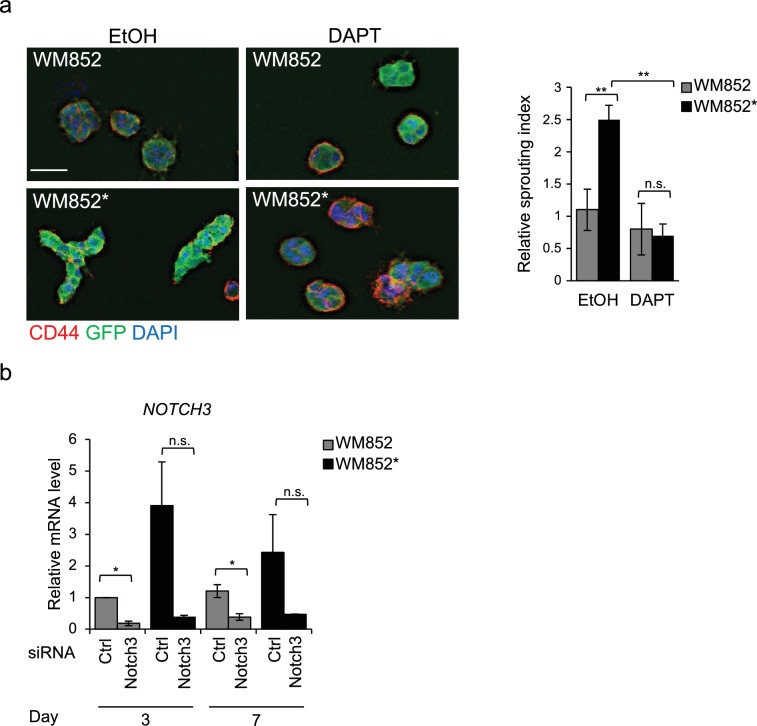
3D growth phenotype of metastatic melanoma cells is Notch3 dependent.(a) Representative images (left) and quantification (right) of 3D fibrin assay of WM852 and WM852* treated with vehicle (EtOH) or DAPT for 48 hr during co-culture, after magnetic separation and also during the 3D fibrin assay. Relative sprouting index from three independent experiments is shown; **: p<0.01; n.s., non-significant. (b) NOTCH3 mRNA fold change in WM852 and WM852* treated with the indicated siRNAs for 72 hr and subjected to magnetic separation after co-culture and analysed at the indicated time points. *: p<0.05; n.s., non-significant.